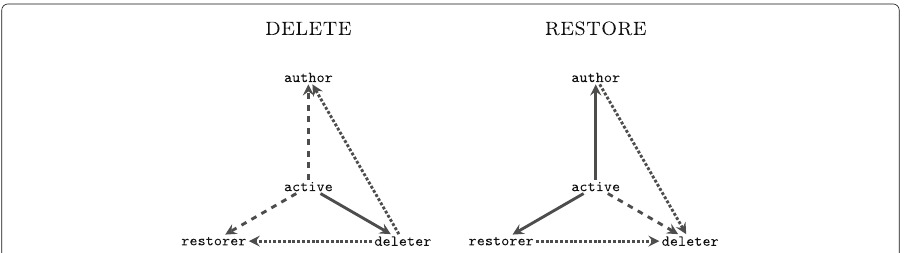
Fig. 3 Edit events resulting from the deletion of a word ( left ) and a word being restored ( right ). Solidlines encode dyadicredo events by which the active user re-does the target user’s edit. Dashedlines encode dyadic undo events by which the active user makes the target user’s edit undone. Dottedlines encode third-partyedit events by which the active user re-does the source user’s edit that has been made undone by the target user. After deleting a word w the user active becomes deleter ( w ) and after restoring w user active becomes restorer ( w ) . Note that author ( w ) is only set when w is originally added and does